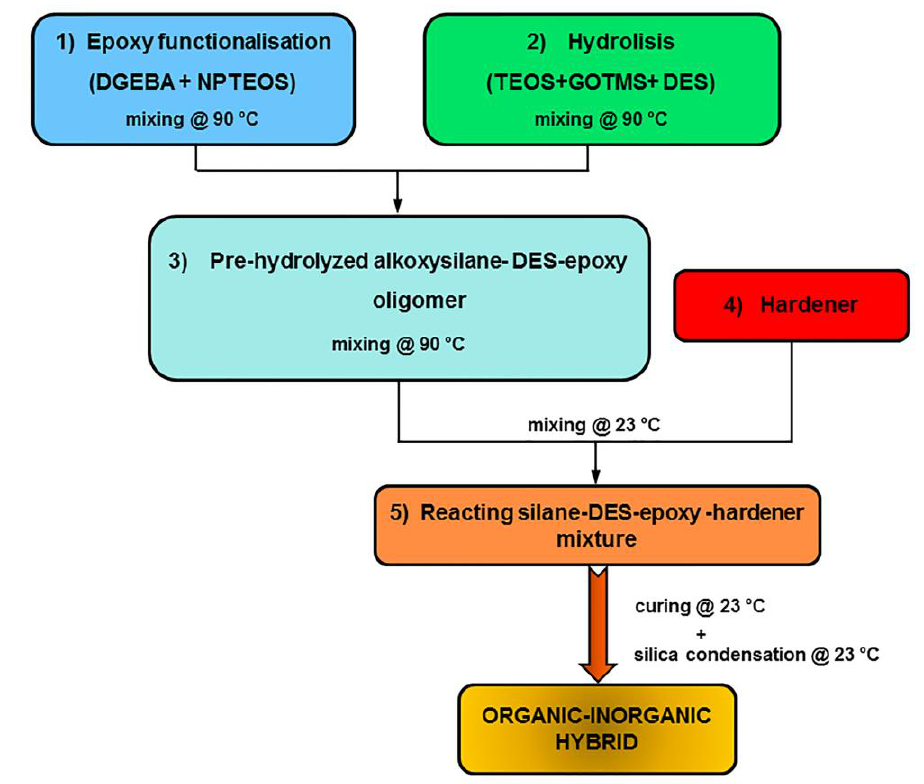
Figure 1. Steps of the synthesis process.